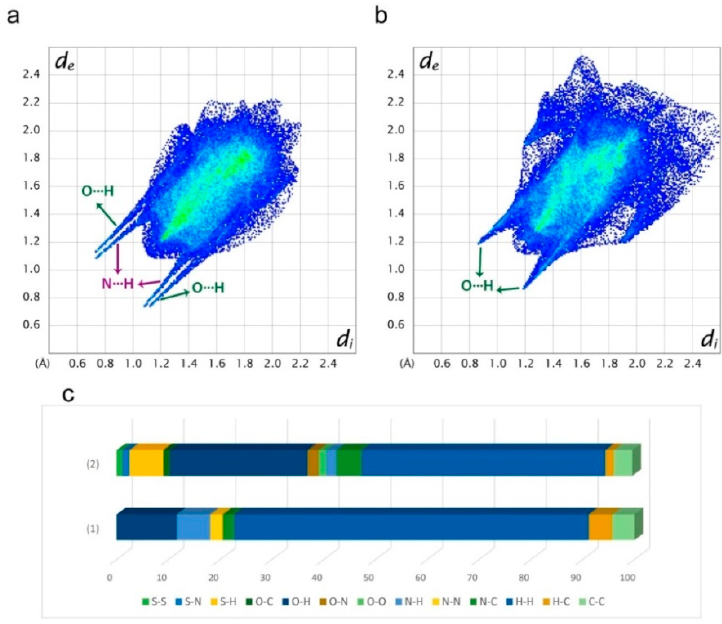
Figure 5. Fingerprint 2D plots for 1 ( a ) and 2 ( b ). Contact percentage contribution of the studied compounds in the surface ( c ).